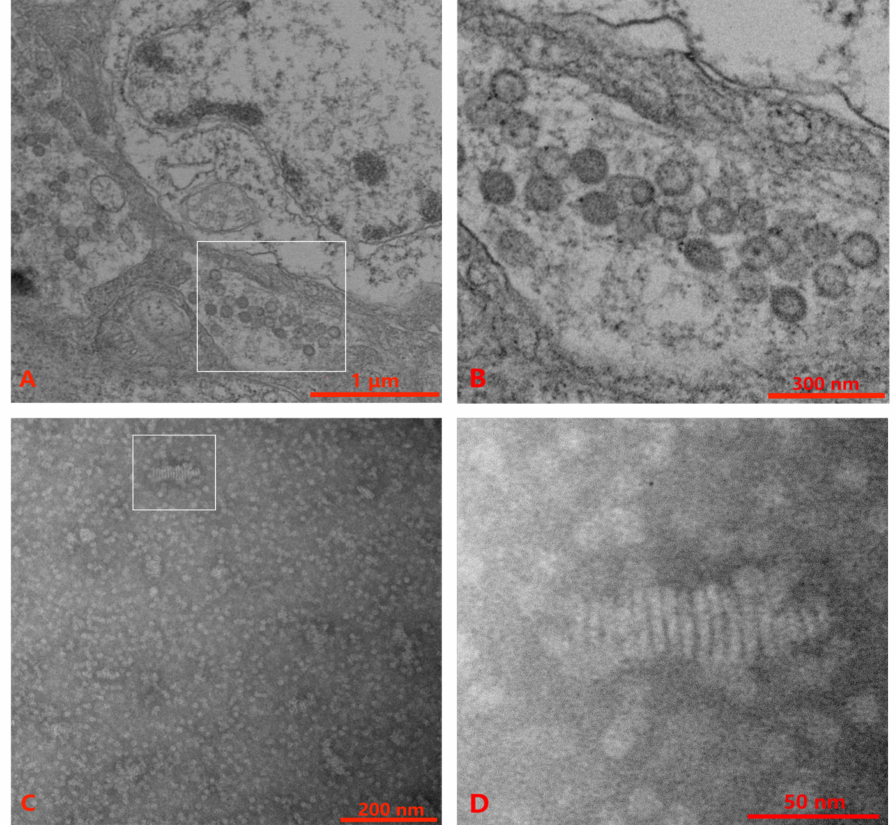
Figure 1. Transmission electron microscopy (TEM) observations of wild P. chinensis . ( A ) Gill tissue with sample number 20211126007. ( B ) High magnification of the gill tissue section reveals